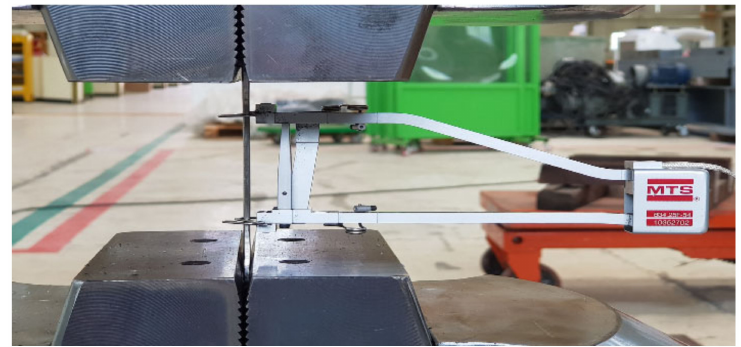
Figure 2. Tensile tests of STS 304